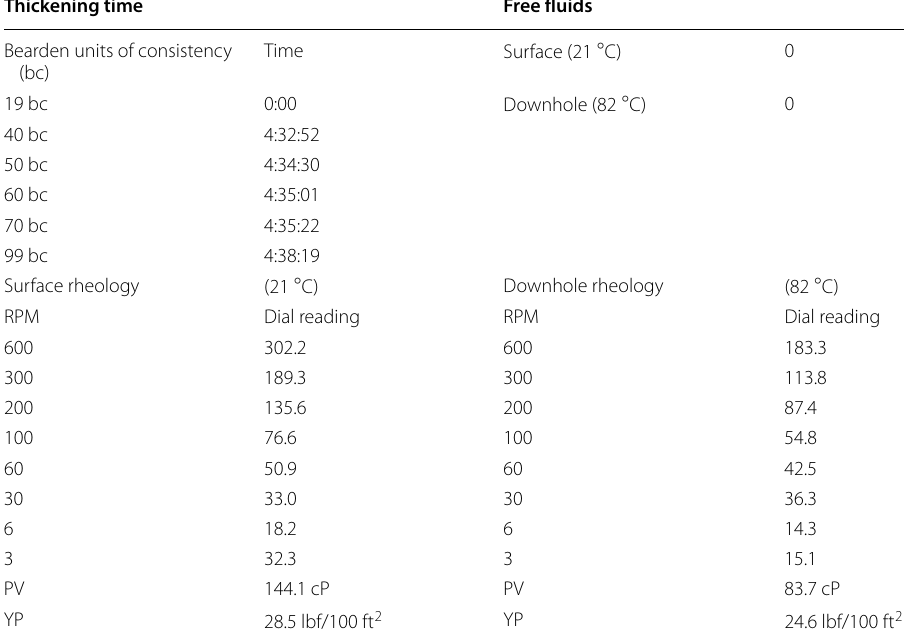
The cementing contractor used a Fann Model 3530A to measure the rheological parameter